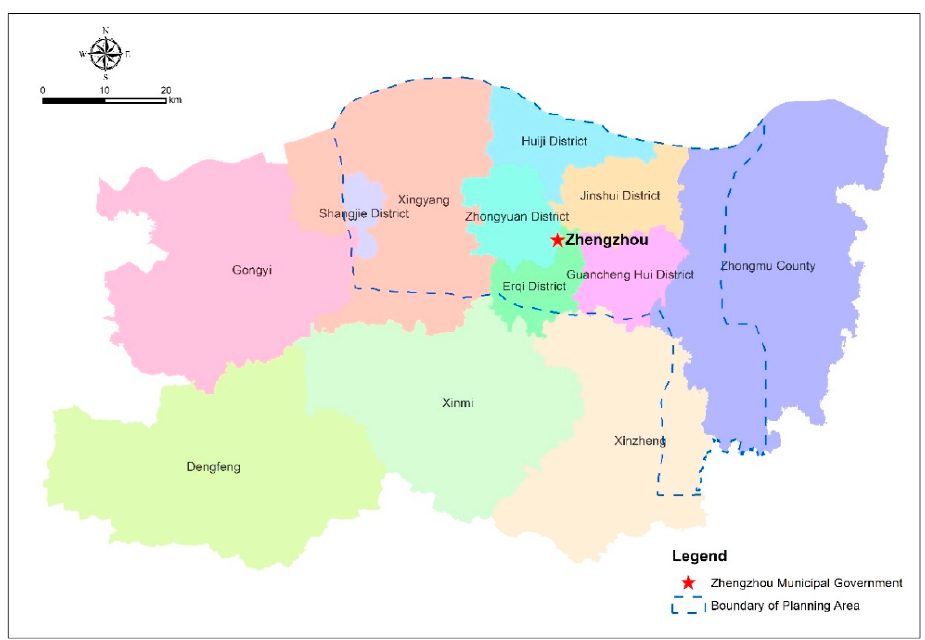
Figure 1. Zhengzhou administrative districts and the sponge city construction planning area. Water 2019 , 11 , x FOR PEER REVIEW